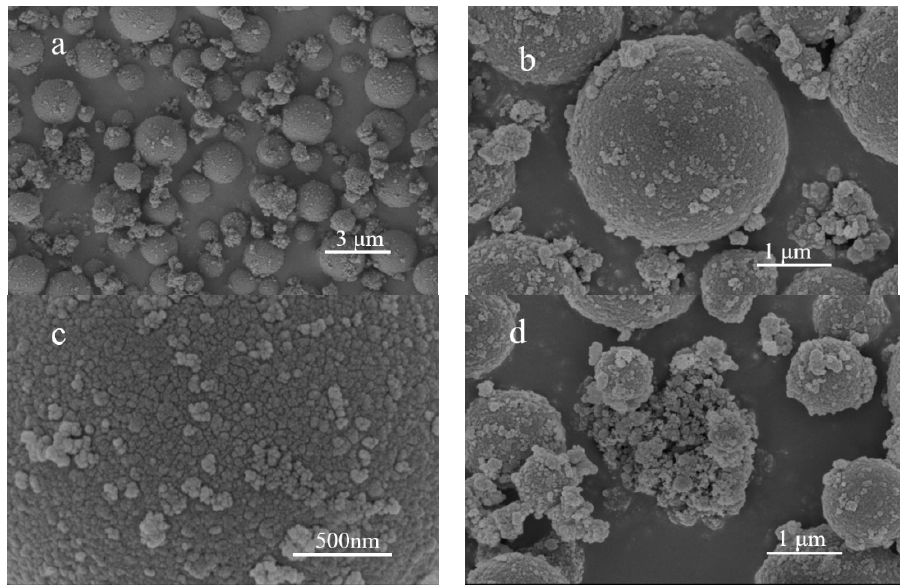
Figure 4. SEM images of the original fluorescent pigment at different magnifications: ( a ) magnifi- cation of 6 k; ( b ) magnification of 20 k; ( c ) magnification of 50 k; ( d ) magnification of 20 k.